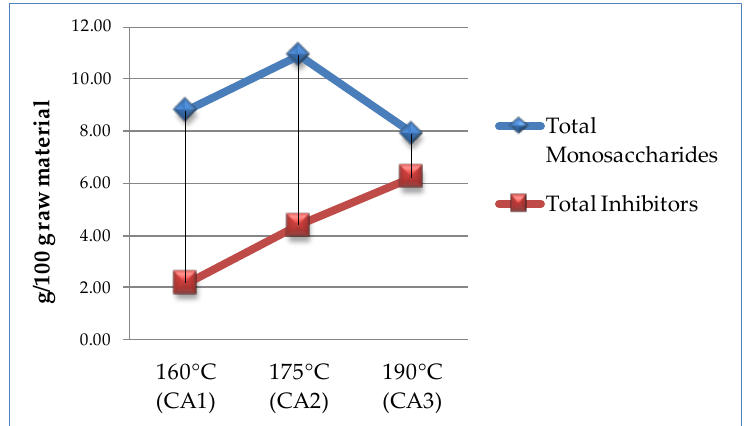
ff erent pre-treatment